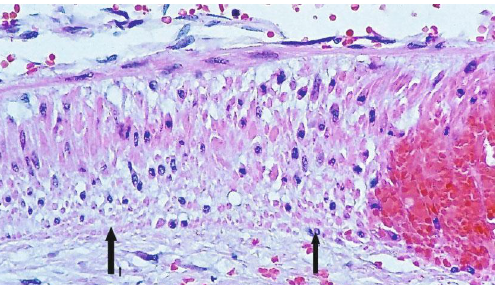
Figure 7: Segmental arterial mediolysis injurious phase. Arrows indicate two foci of apoptosis di ff usely involving the outer media with focal extensions into the mid and inner media. A focal microhemorrhage also is evident in the media. Hematoxylin & eosin × 200 (adapted from EC Cardiology 4(7) 2918, online publication).